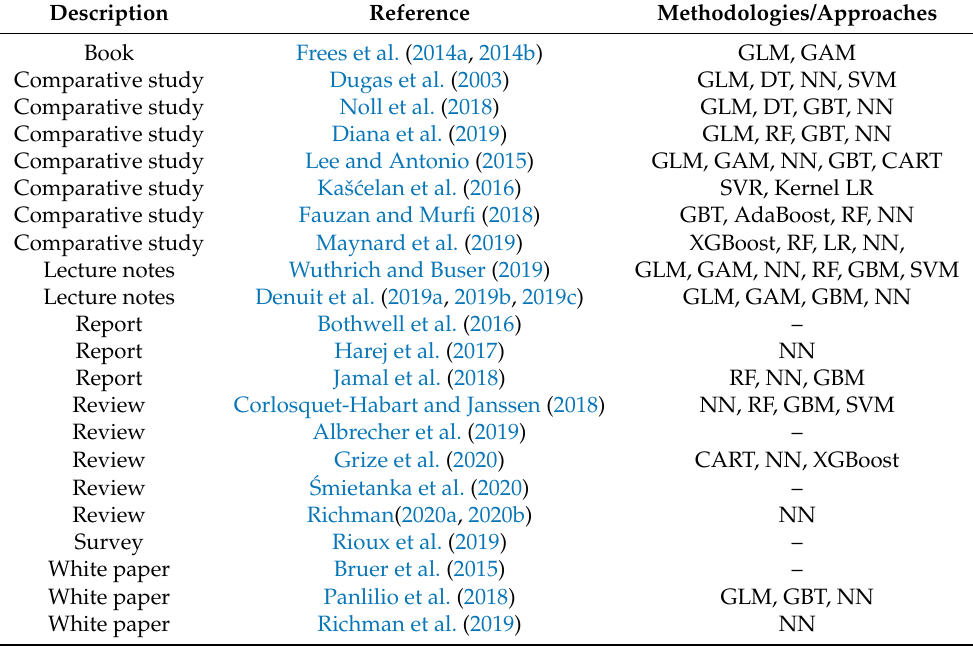
Table 1. Overview papers on machine learning in actuarial